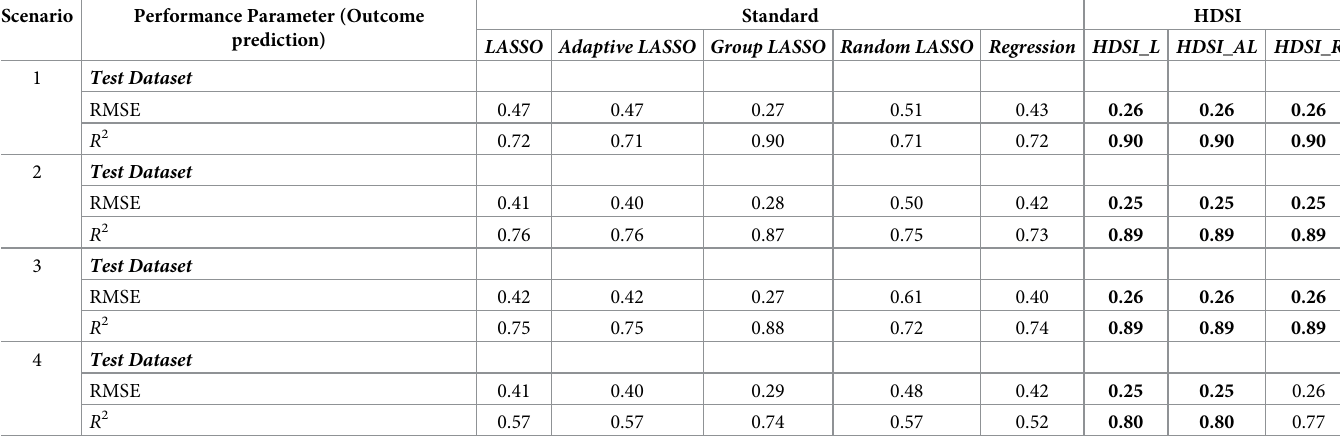
Table 5. Outcome prediction performance of different approaches in simulated